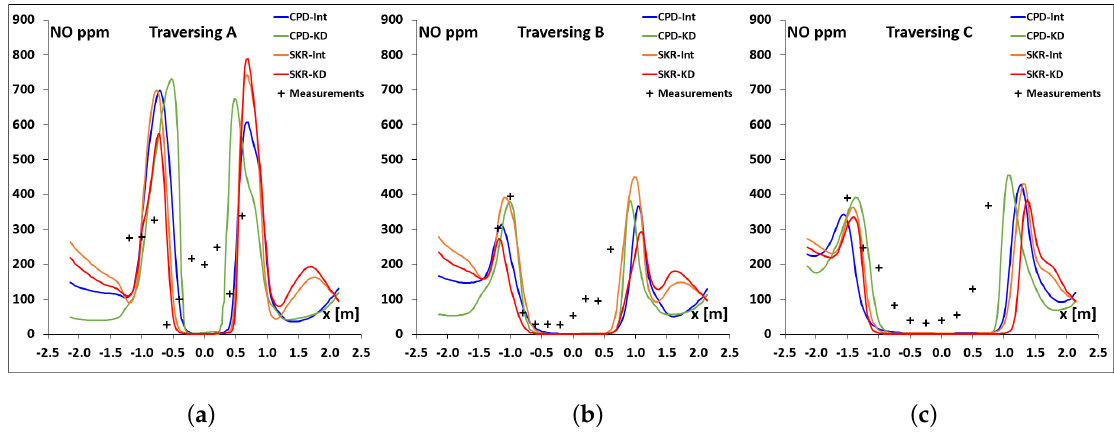
Figure 18. NO molar concentrations distribution along Traverses A ( a ), B ( b ) and C ( c